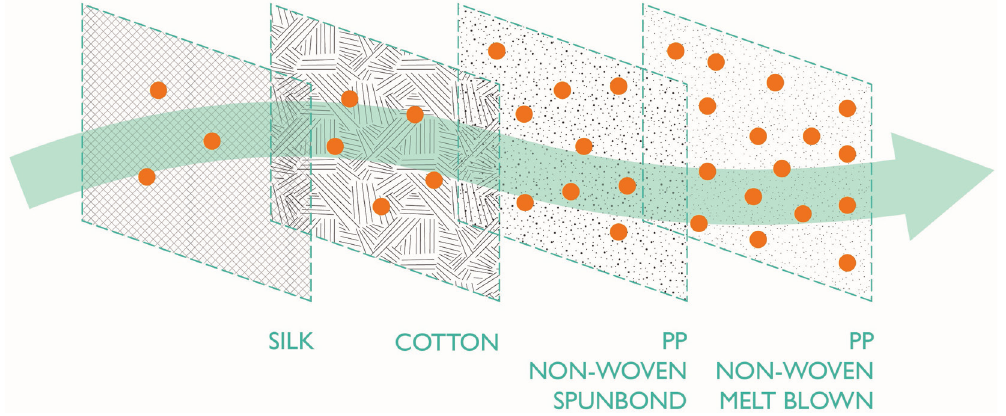
Example of filter materials in their order of filtration efficiency. Typical material filtration efficiencies increase from left to